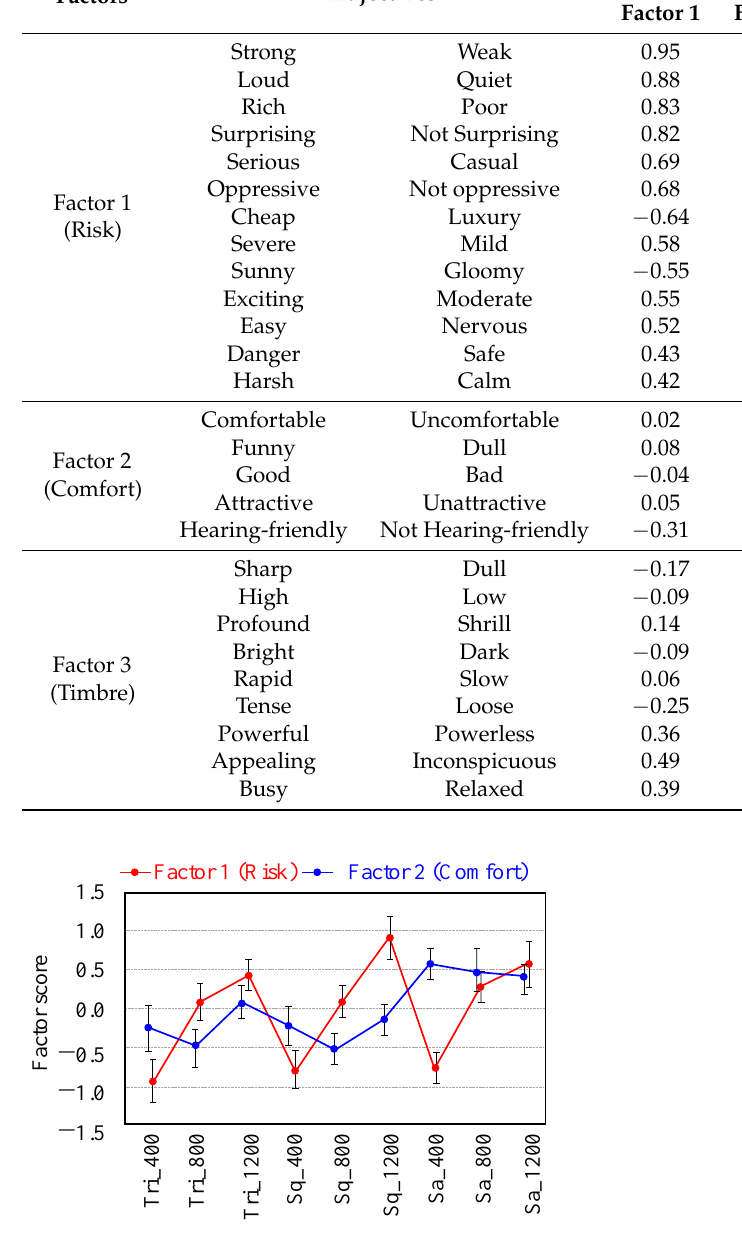
Figure 7. Average factor scores and associated SDs (error bars indicate 95% confidence intervals). Table 4. Experimental results of factor analysis in case of Phase 1.